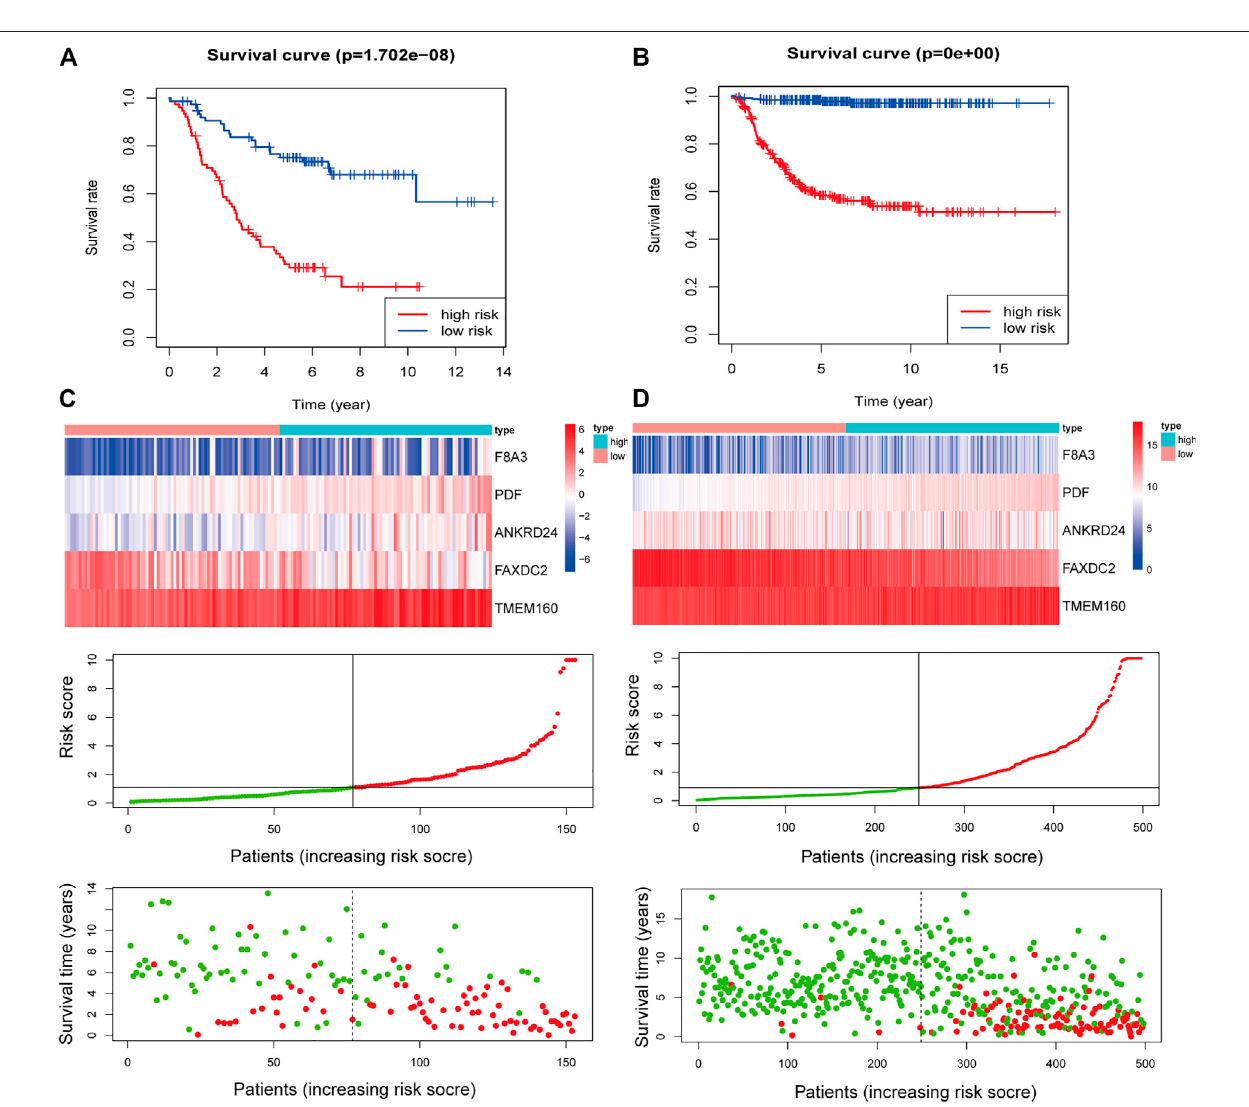
FIGURE5| Construction ofthe fi ve-RNA-based risksignatureofneuroblastomapatients.Kaplan-Meier analysisforoverallsurvival(OS)ofneuroblastoma patients based on the risk strati fi cation in the TARGET cohort (A) and GSE49711 cohort (B) . (C) The fi ve-RNA-based risk score distribution, the living status of neuroblastoma patients, and heatmap of the fi ve gene expression pro fi les in the TARGET cohort. (D) The fi ve-RNA-based risk score distribution, the living status of neuroblastoma patients, and heatmap of the fi ve gene expression pro fi les in the GSE49711 cohort.